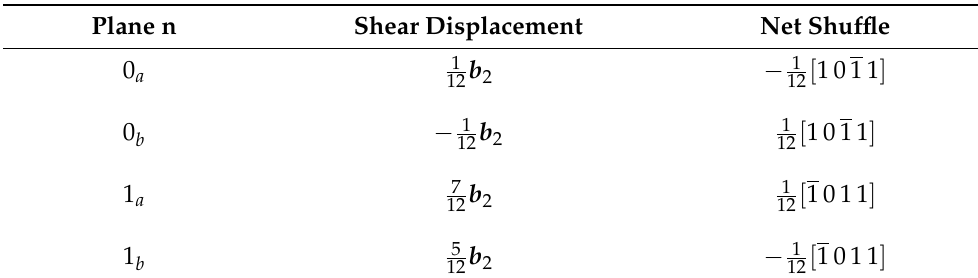
Table 2. Shear displacements and net shuffles for b 2 twinning dislocation for the { 1012 } twin- ning